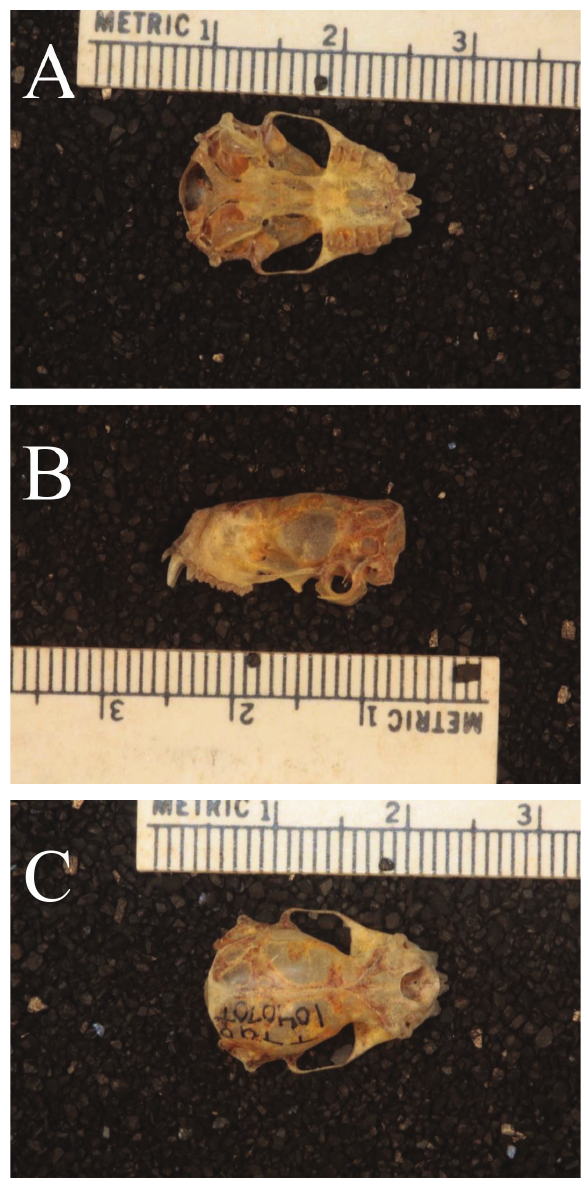
Figure 2. A ventral, B lateral and C dorsal views of the skull of C. mexicanus (TTU 104070) captured in the SAG, La Ceiba in the deparment of Atlántida in northern